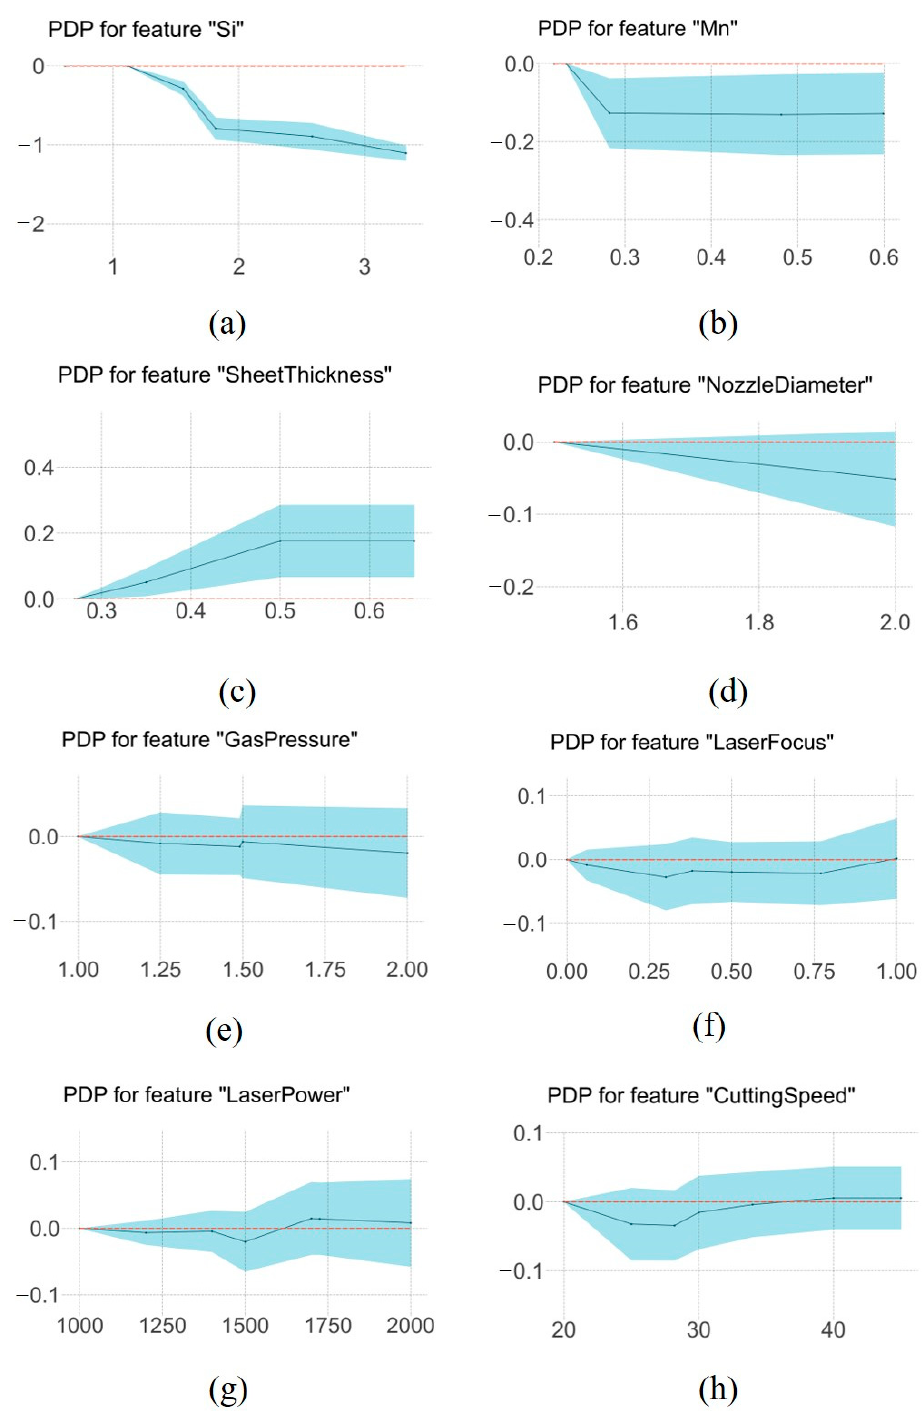
Figure 8. The influence of the features on the specifical total loss. Partial dependence of specific Figure 8. The in fl uence of the features on the speci fi cal total loss. Partial dependence of speci fi c total total loss on ( a ) Si content, ( b ) Mn content, ( c ) steel sheet thickness, ( d ) laser nozzle diameter, ( e ) the loss on ( a ) Si content, ( b ) Mn content, ( c ) steel sheet thickness, ( d ) laser nozzle diameter, ( e ) the pressure of the process gas, ( f ) laser defocus, ( g ) laser power and ( h ) laser cutting speed. The X -axis pressure of the process gas, ( f ) laser defocus, ( g ) laser power and ( h ) laser cu tt ing speed. The X -axis represents the value range of the features, while the Y -axis represents the change of the predicted represents the value range of the features, while the Y -axis represents the change of the predicted specific total loss with the increasing value of the interested features. Units for X -axis: Density, g/cm 3 ; speci fi c total loss with the increasing value of the interested features. Units for X -axis: Density, LaserDiameter, mm; CuttingSpeed, m/min; LaserPower, W; GasPressure, MPa; LaserDefocus, mm, g/cm 3 ; LaserDiameter, mm; Cu tt ingSpeed, m/min; LaserPower, W; GasPressure, MPa; LaserDefo- Thickness, mm; Si, Al and Mn, wt% and Resistivity, µ Ω · cm, and Units for Y -axis: SpecificTotalLoss, cus, mm, Thickness, mm; Si, Al and Mn, wt% and Resistivity, µ Ω ·cm, and Units for Y -axis: W/kg. The confidence interval is shaded in blue for each Speci fi cTotalLoss, W/kg. The con fi dence interval is shaded in blue for each fi gure.